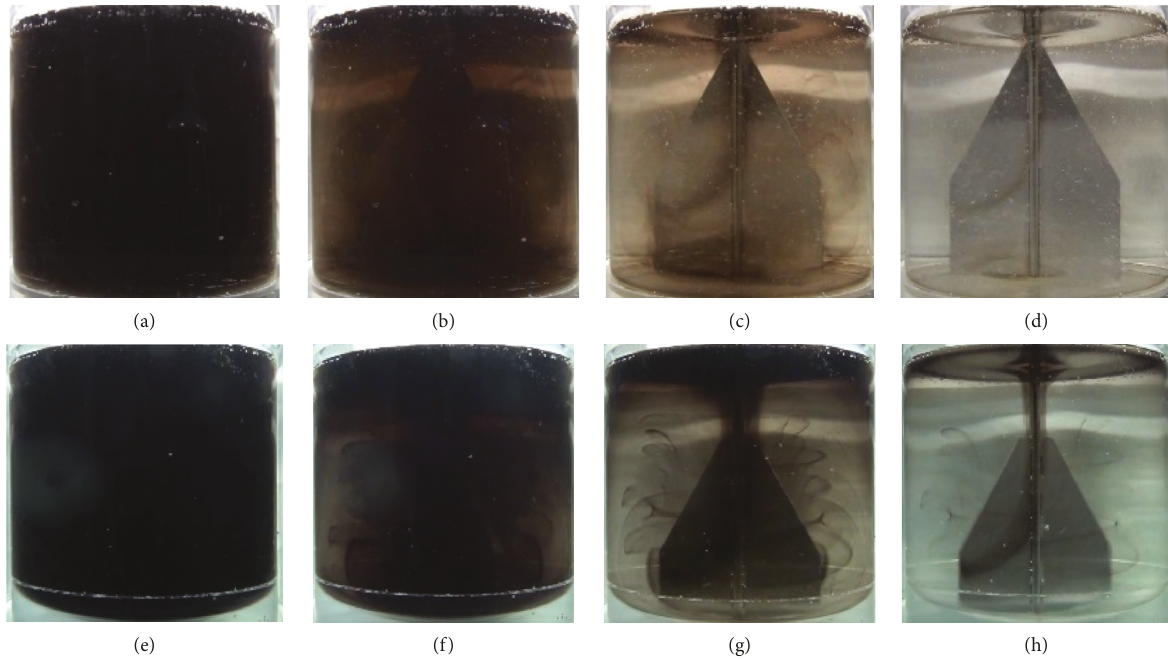
Figure 6: Mixing process of HB impeller at Re � 100, flat bottom ((a) 0s, (b) 10s, (c) 15s, and (d) 30s) and dished bottom ((e) 0s, (f) 10s, (g) 15s, and (h) 30s) ( μ � 0.29Pa · s, ρ � 1,327kg/m 3 , and n �